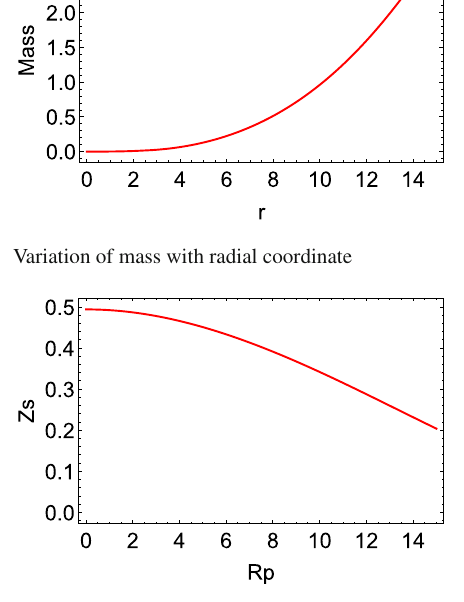
Fig. 12 Variation of surface redshift with radial